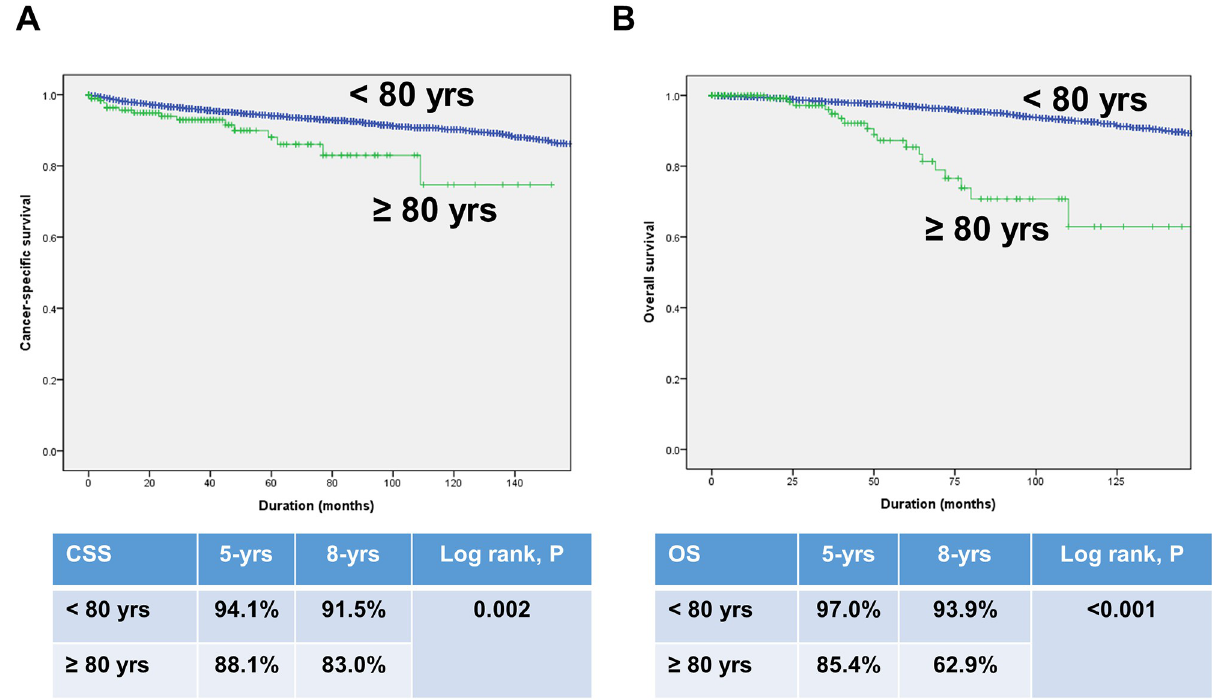
Fig 1. Kaplan-Meier curves for cancer-specific survival (A) and overall survival (B) in patients by age group (octogenarian vs. younger group).